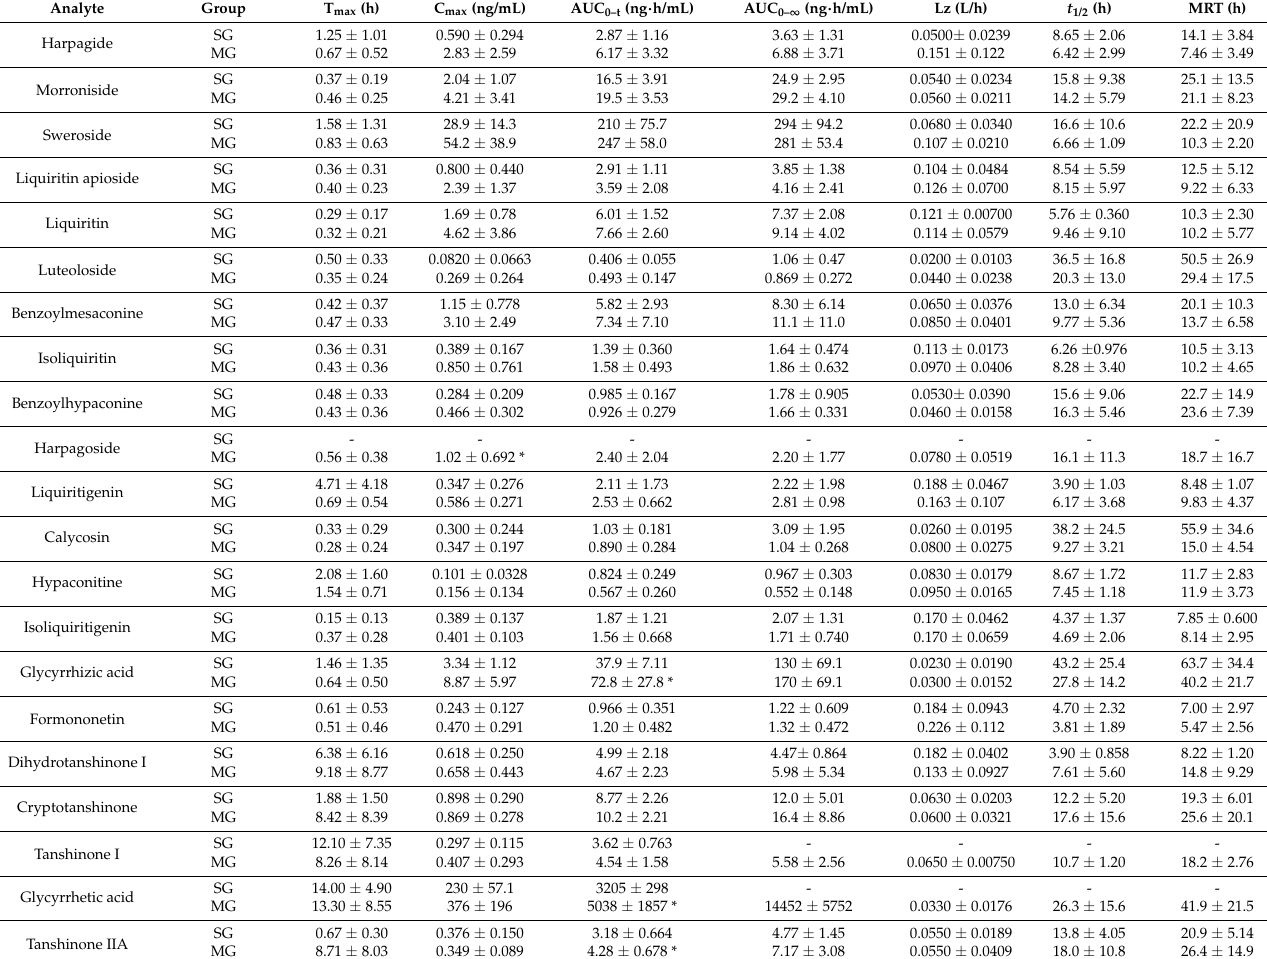
Table 7. Pharmacokinetic parameters (mean ± SD) of analytes after oral administration of QSKL in rats ( n =